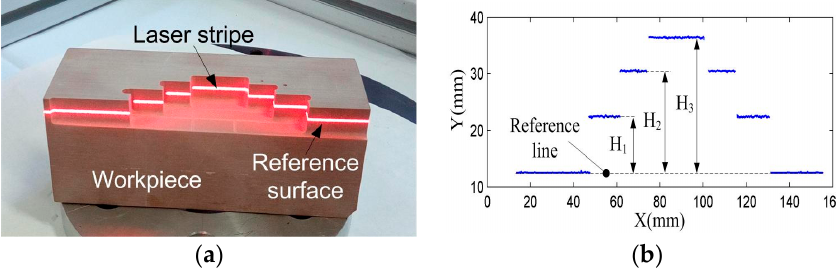
Figure 8. Measuring the stairs profile: ( a ) the workpiece with the stairs; ( b ) the measured results. Table 3. Measured results of the stairs.